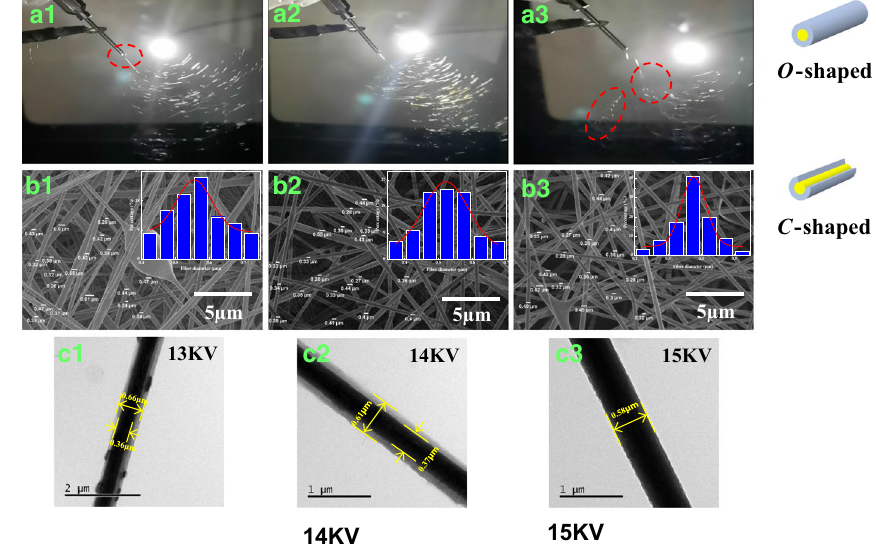
Table 1 Effect of PAN and PVDF’s concentration on the diameter and integrity of the nanofibers